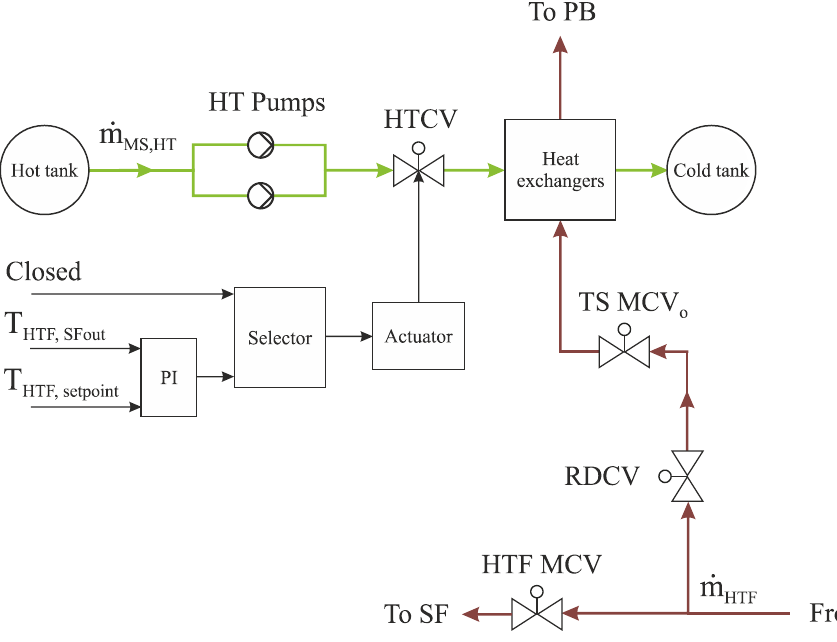
Figure 12. Hot tank control valve (during discharge mode) (simplified).